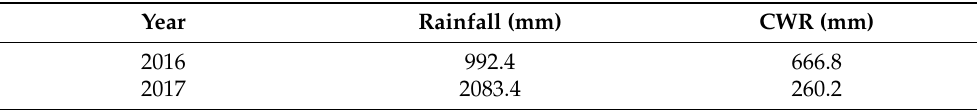
Table 4. CWR values for Serting Estate for 2016 and